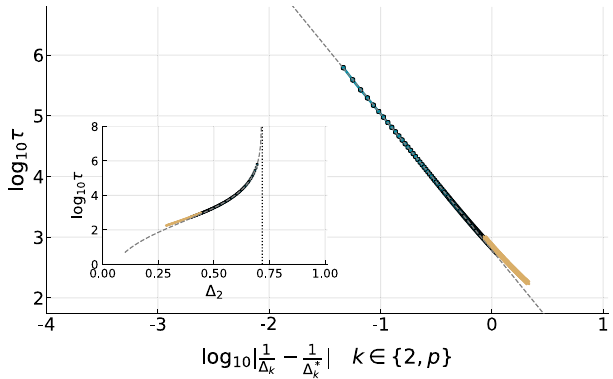
FIG. 2. Evolution of the correlation with the signal ¯ C ð t ¼ 0 Þ ¼ 10 − 4 in the Langevin algorithm at fixed noise from on the matrix ( Δ 2 ¼ 0 . 7 ) and different noises on the tensor ( Δ